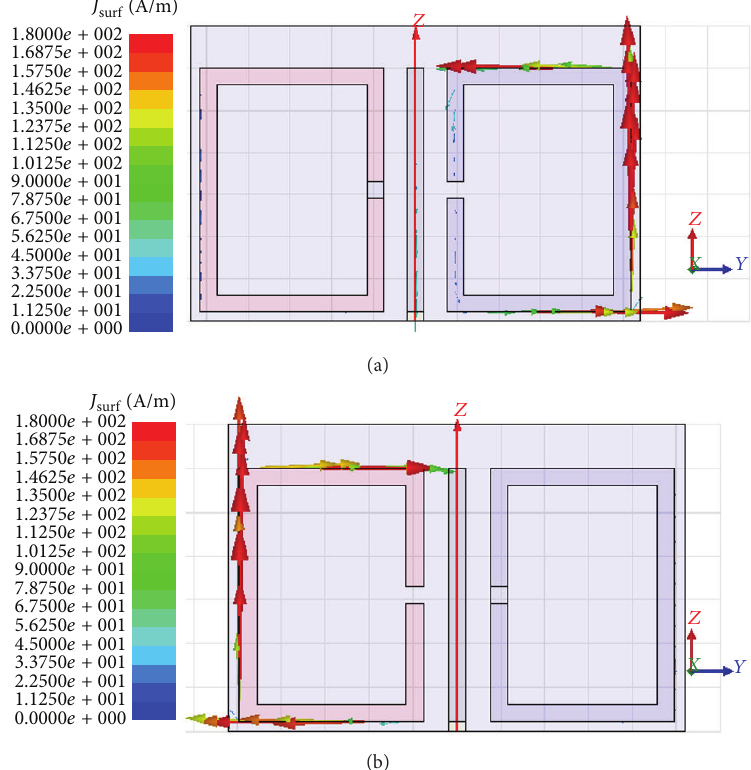
Figure 12: Simulated surface current for the two-element reconfigurable antenna at 𝑓 𝑅 = 1.172 GHz: (a) S1 ON and S2 OFF, and (b) S1 OFF and S2